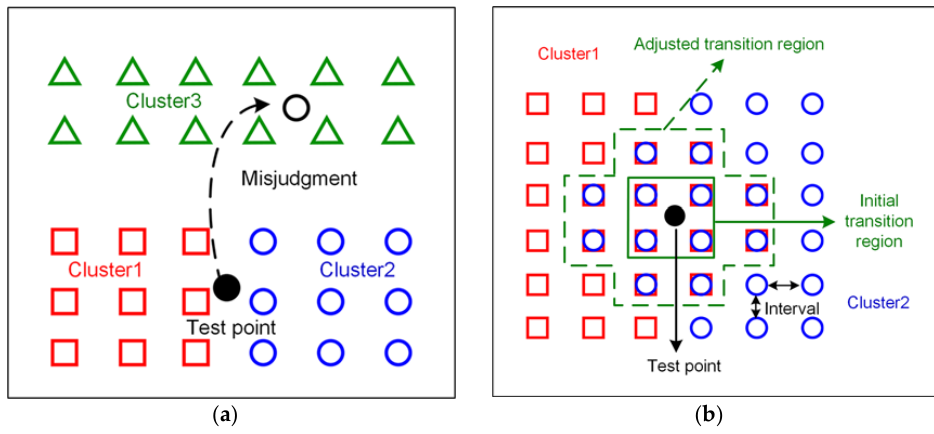
Figure 2. The phenomena of cluster misrecognition and the illustration of adjusting cluster based on transition region, ( a ) misjudgments usually take place on the margin between two adjacent clusters and dynamic huge RSS readings change; ( b ) the marked area in dash box is the adjusted transition region, it belongs to both the Cluster 1 and the Cluster 2.